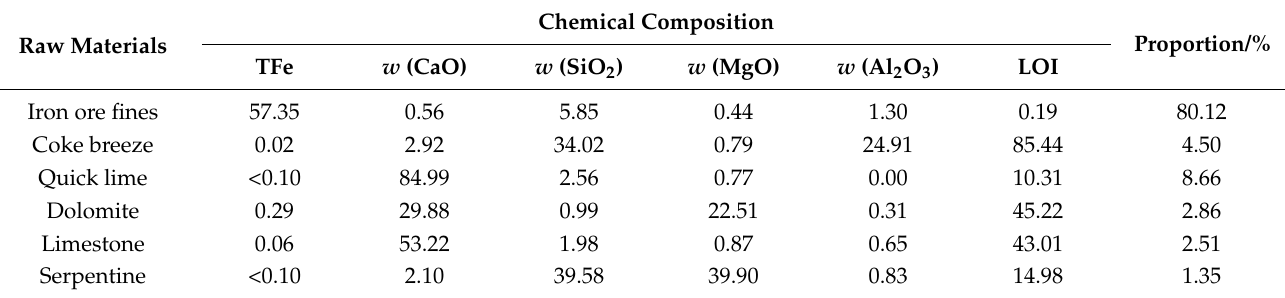
Table 2. Compositions and proportions of the raw